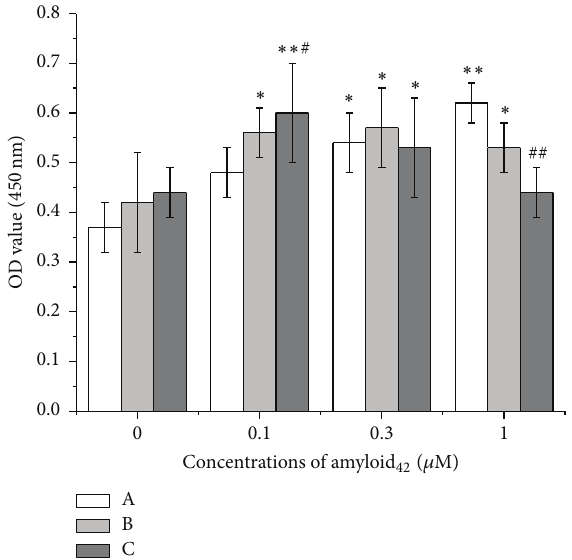
Figure3:ThetimecourseofNSPCsviabilityaftercoincubationwith . Cell viability was measured by different concentrations of A 𝛽 1 – 42 was 0.1, 0.3, and 1 𝜇 M, the CCK-8 assay. The concentration of A 𝛽 1 – 42 respectively. The error bars represent the standard error of the mean (S.E.M.) of at least three experiments ( 𝑛 = 3 ). ∗ 𝑃 < 0.05 , ∗∗ 𝑃 < 0.01 versus control group. # 𝑃 < 0.05 , ## 𝑃 < 0.01 versus 0.1 𝜇 M A 𝛽 1 – 42 group. (A) Six days, (B) 9 days, and (C) 12